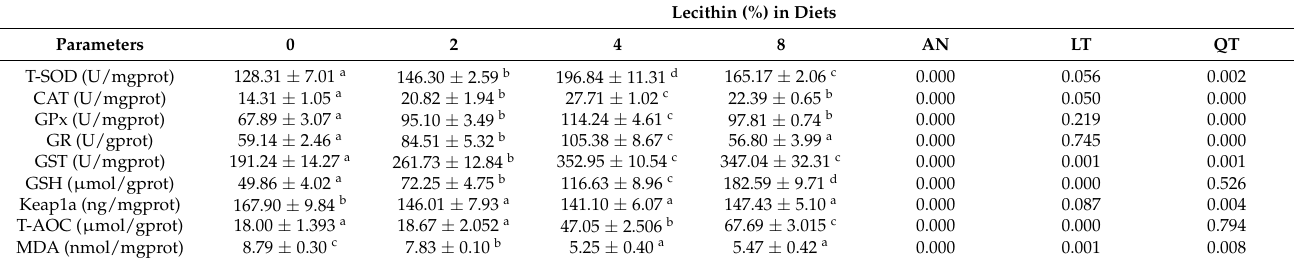
Table 5. Effects of dietary soybean lecithin on the antioxidative and oxidative indices in the intestine